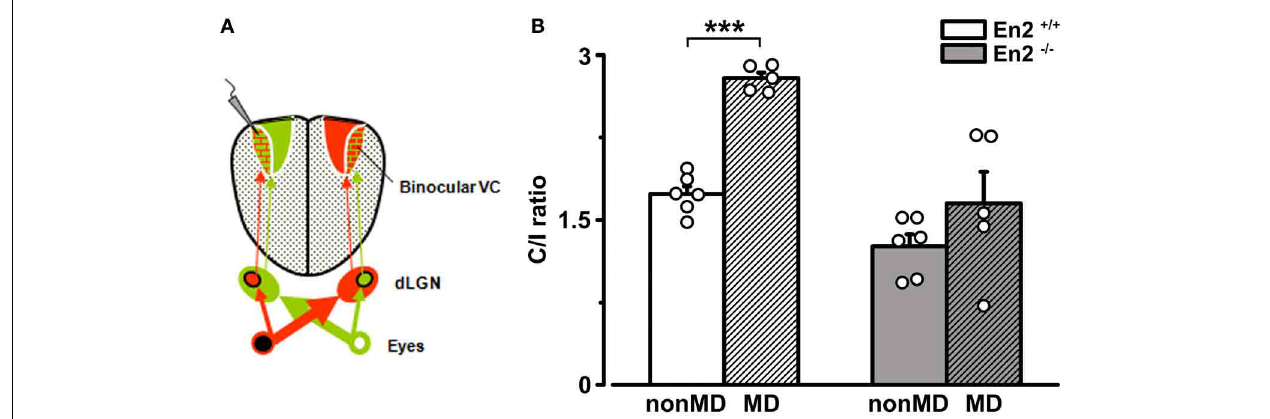
FIGURE 8 | Juvenile En2 − / − mice do not exhibit OD plasticity after brief MD in the hemisphere ipsilateral to the deprived eye. (A) Schematics of the experimental protocol for VEP recordings performed ipsilateral to the deprivation. (B) C/I VEP ratios in En2 + / + (white) and En2 − / − (gray) mice either